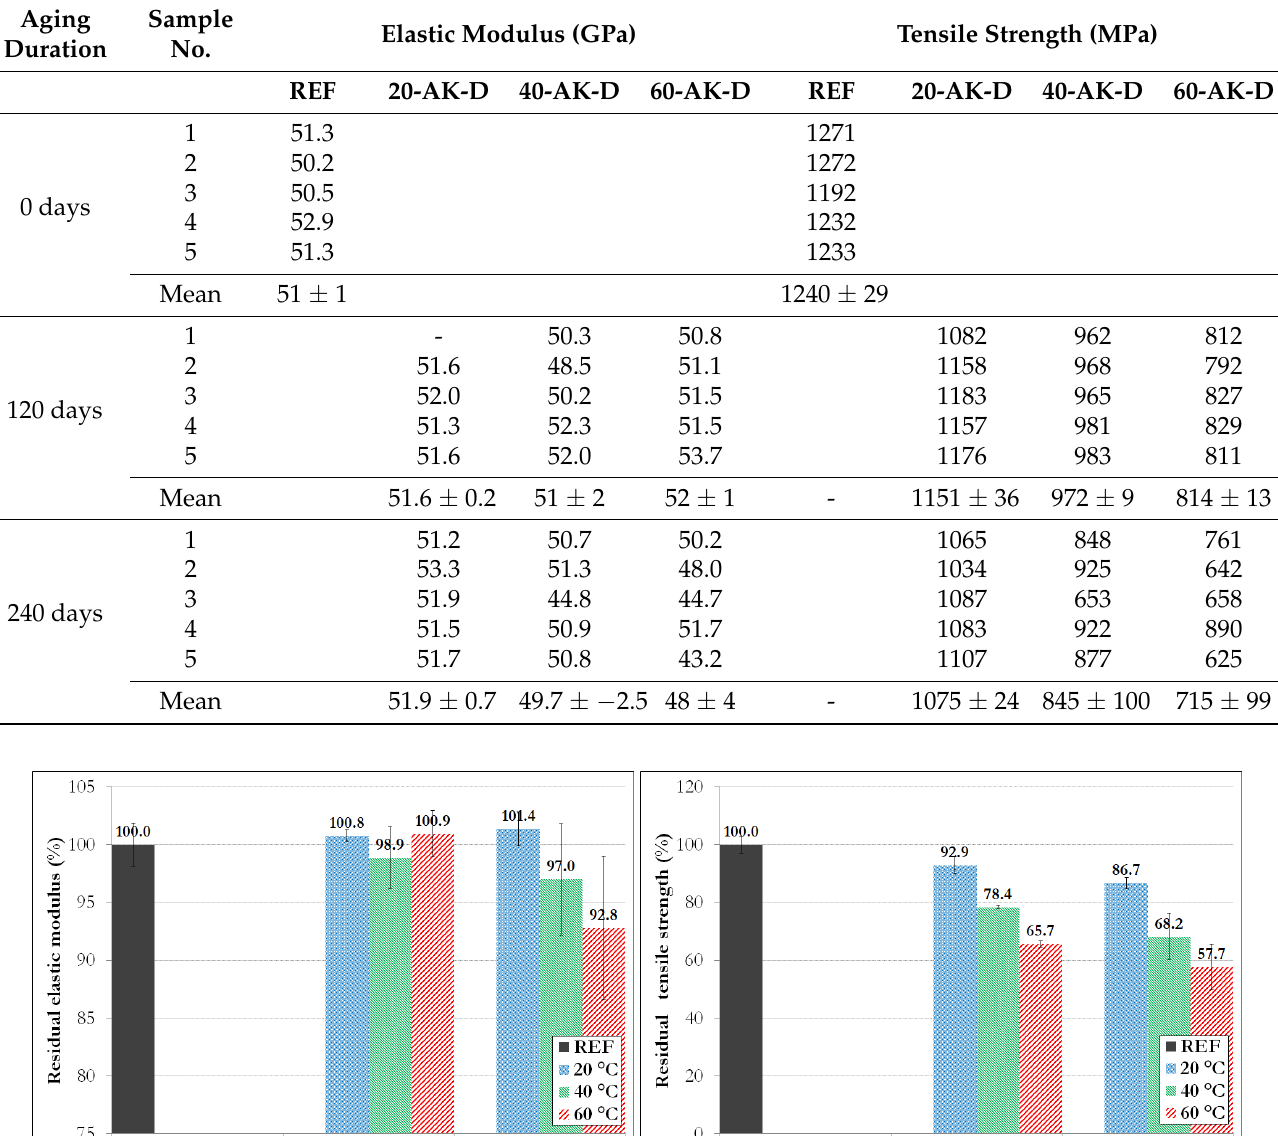
Table 6. Results of tensile tests performed on GFRP rebars exposed to direct immersion in the alkaline solution. Results obtained for unaged reference rebars are also reported (REF).